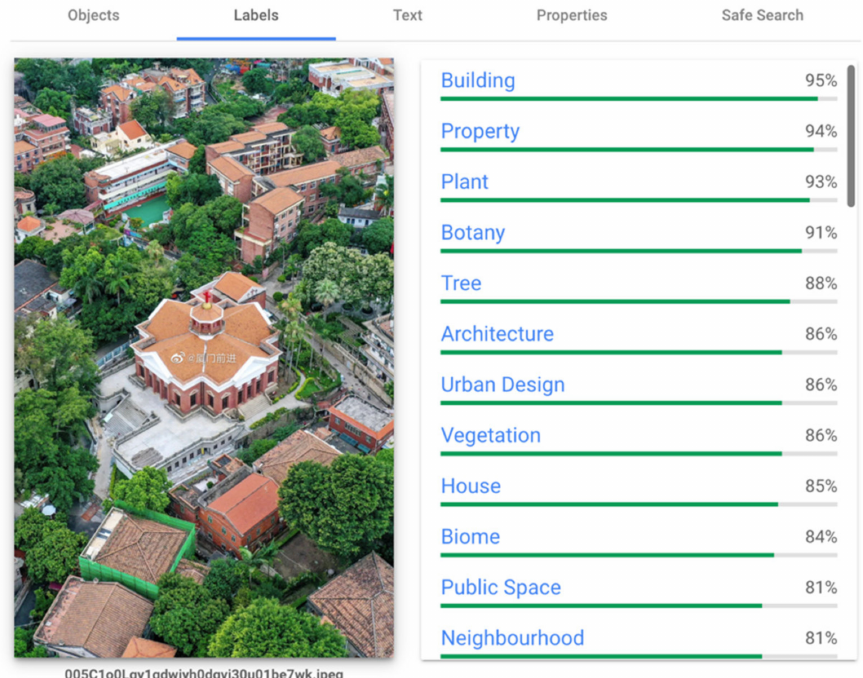
Figure 6. An example of using Google Vision to label images using a picture of the bird’s-eye view of the Kulangsu Historic Settlement obtained from